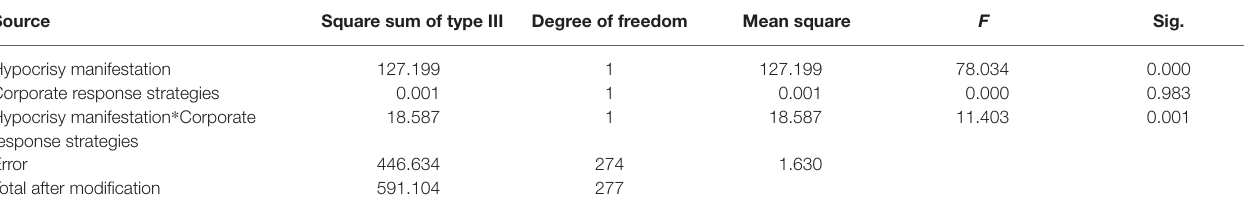
Dependent variable: mean value of negative